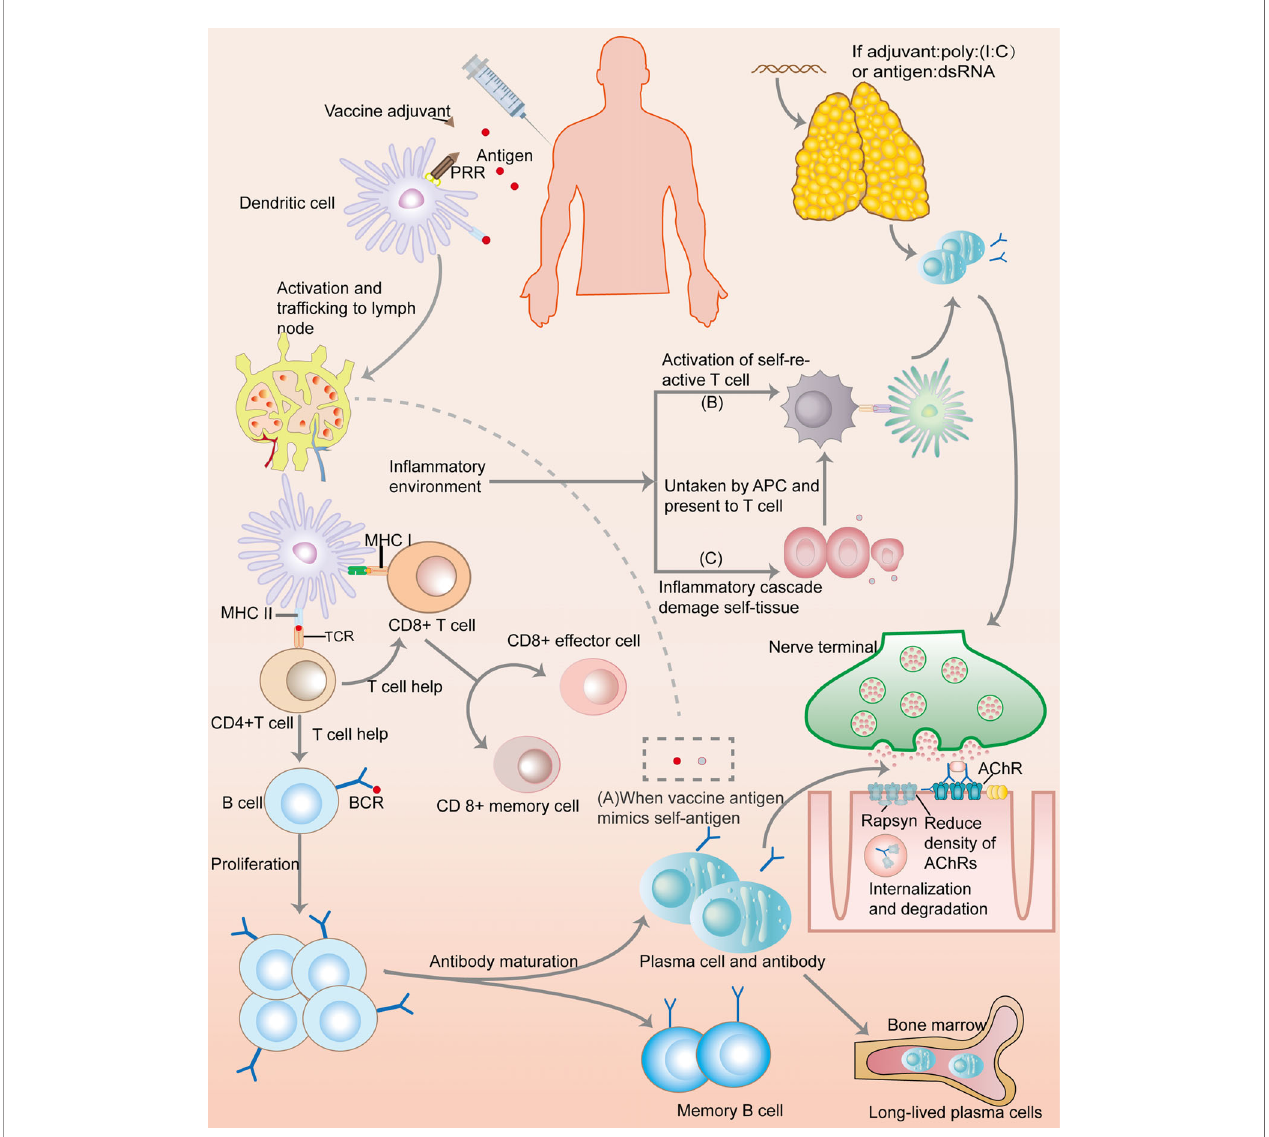
transportation to lymph nodes where the presentation of vaccine antigen by MHC molecules would lead to the activation of T cells through combining to T cell receptor (TCR). With the help of CD4+T cells, B cells undergo activation and proliferation, leading to antibody maturation and the appearance of short-lived and long- lived plasma cells, as well as memory B cells. CD8+T cells also develop into CD8+effector cell and memory cells. This immunization processes create a special in fl ammatory environment which correlates with the mechanisms of autoimmune: (A) Molecular mimicry: If vaccine antigens share great similarity with self-antigens, autoimmune reaction may ensue because the immune response to the vaccine antigens can crossreact with self-antigens. (B) Bystander effect: immune responses to vaccine antigens can induce in fl ammatory signals, inadvertently resulting in the activation of self-reactive T cells, and thus the autoimmune processes. (C) Epitope spreading: in fl ammatory cascades cause tissue damage, and the presentation of self-antigens would trigger the activation of self-reactive T cells. Additionally, if a vaccine contains dsRNA or its analog, such as poly(I:C), it can trigger a thymic overexpression of IFN- b , leading to MG through overexpression of AChR, DCs autosensitization, abnormal recruitment of B cells, and GC